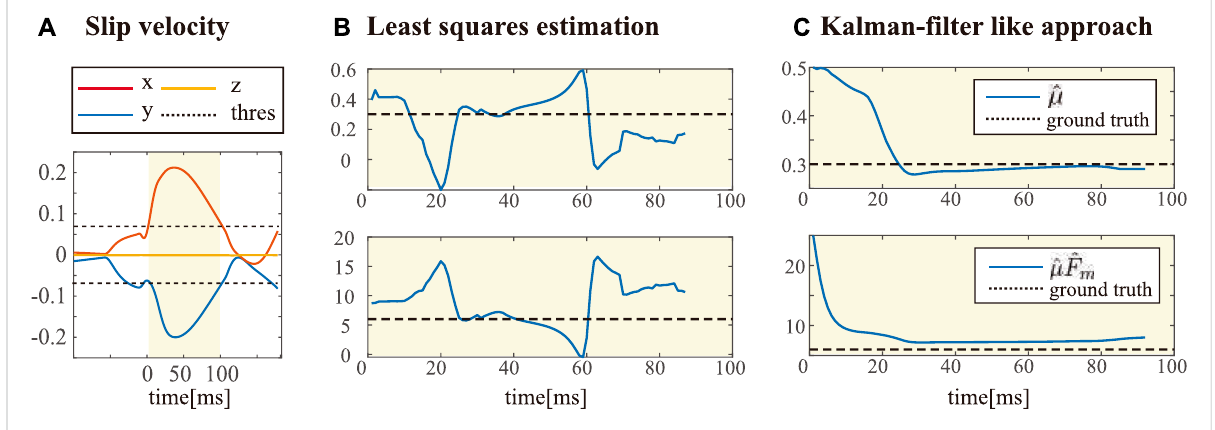
FIGURE 6 Estimation of unknown environment parameters (cid:2) [ μ , μ F m ] ⊤ during the slip condition. (A) shows the condition of the estimation activation. Once the contact velocity exceeds the threshold during the certain amount of time, we declare the slip detection so that the estimation can be executed. Yellowareas intheplots represent where theestimation isactivated. (B) and (C) present theresulting estimationobtained bytwo different approaches, least-squares, and Kalman fi lter – like